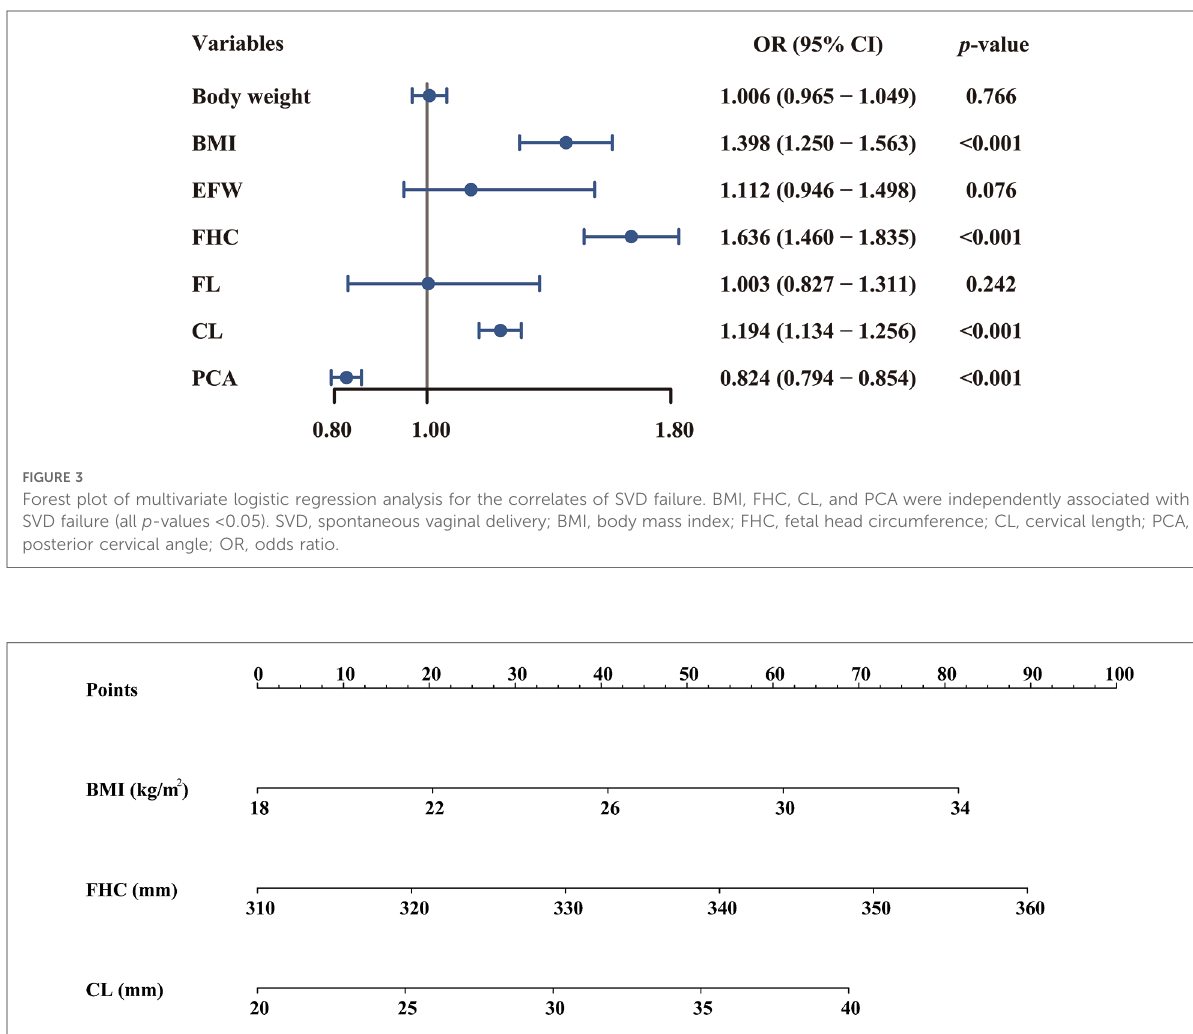
women ( Figure 6B ). The application of the prediction model before the labor onset will bene fi t the majority of nulliparous women.